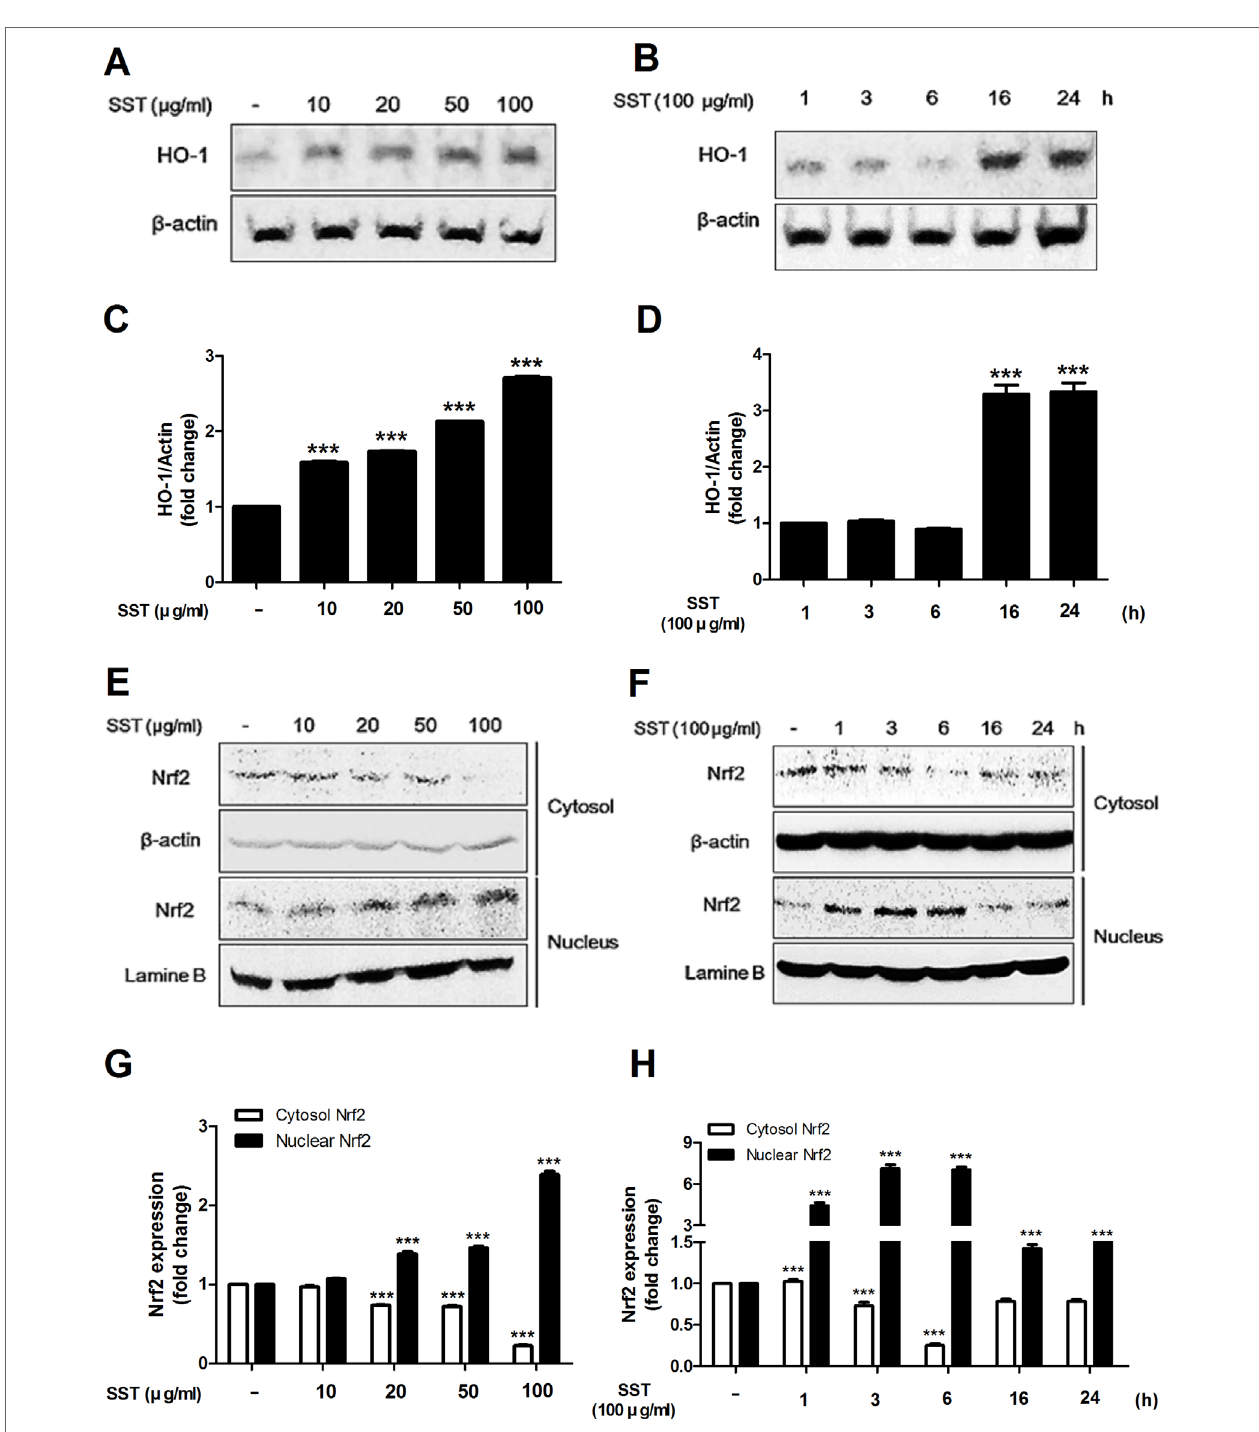
FIGURE 3 | Effects of SST on heme oxygenase-1 (HO-1) expression and Nrf2 activation. HaCaT cells were treated with various concentrations of SST for 24 h (A, C) or with 100 μ g/ml SST for various lengths of time (B, D) . HO-1 protein levels were detected using western blot. HaCaT cells were treated with SST for indicated various concentrations for 24 h (E, G) or with 100 μ g/ml SST for various lengths of time (F, H) . The activations of cytosolic and nuclear Nrf-2 were analyzed using western blotting. The data are shown as mean ± SEM of triplicate experiment. ***p < 0.001 vs. no-treatment